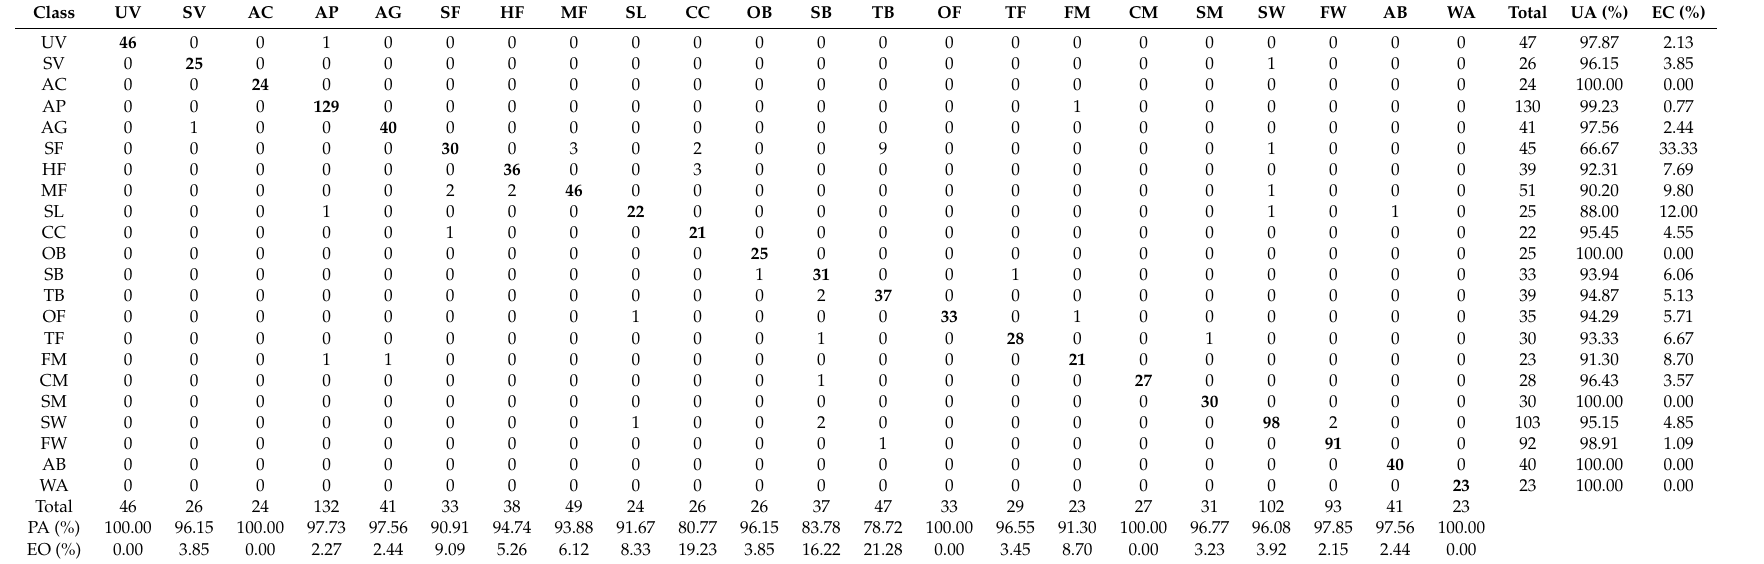
Table 10. Confusion matrix (in number of sites) and associated accuracies when comparing the RF-classified image to 951 in-situ GPS field